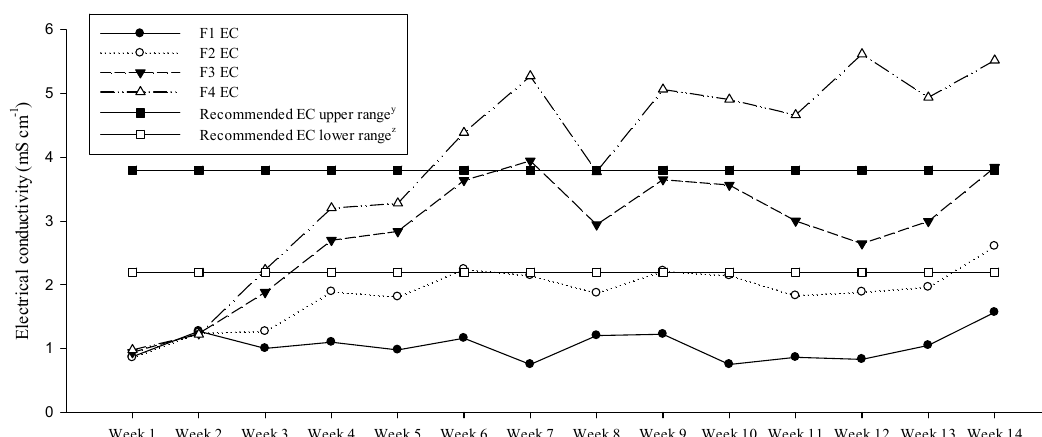
Figure 1. Weekly electrical conductivity (EC) of root substrate amended with biochar at different percentages, after four different fertigated regimes were initiated from week 3 (6 September 2013) and ended in week 15 (5 December 2013, termination of the experiment); y EC level considered as high for greenhouse poinsettia production using pour-through method [27]; z EC level considered as low for greenhouse poinsettia production using pour-through method [27].